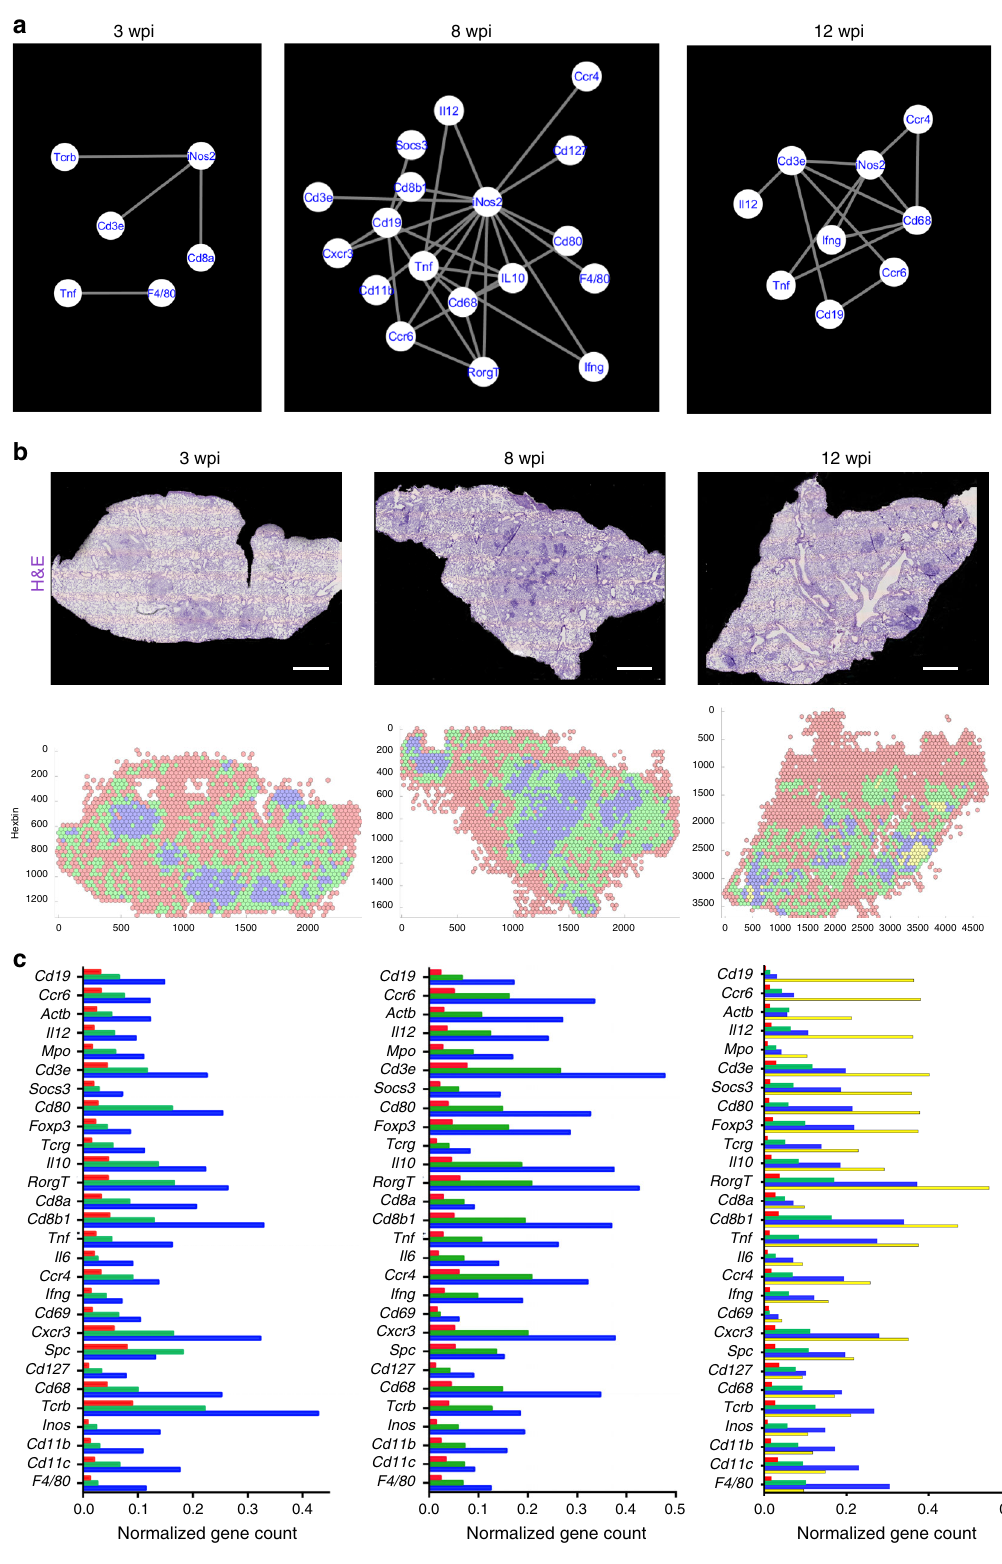
(Fig. 2b and Supplementary Fig. 1). In contrast, at 12 wpi the clusters contained different relative frequencies of transcripts (Fig. 2b, c). Three of the four hexbin clusters located in the granuloma area. One of these (green) also localized in areas surrounding the granuloma (Fig. 2b). Another cluster (yellow) overlapped with lymphoid-rich areas within the granuloma